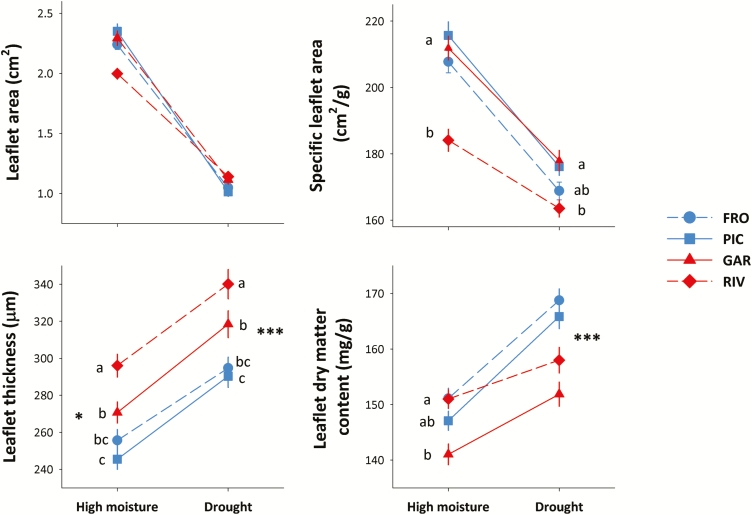
Population differences in leaflet morphology and structure in two contrasting water availability treatments. Each line shows the norm of reaction of each of two northern (blue) and two southern (red) populations for a given trait. Observed population means ± SE are shown for 21 families per population, with three replicates per family and treatment. Significant regional differences in each watering treatment are shown with asterisks (no asterisk: not significant differences; *P < 0.05; **P < 0.01; ***P < 0.001). Different letters indicate significant differences among populations in mean trait values within each watering treatment, according to Tukey post hoc tests. N = 504 plants for all traits. Population codes are those in Fig. 1.